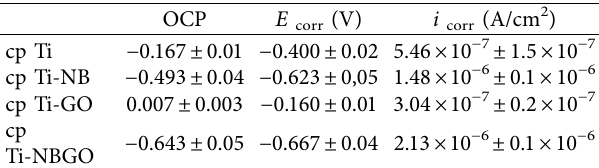
Table 4: Open potential circuit (OCP), corrosion potential ( E and current density ( i corr